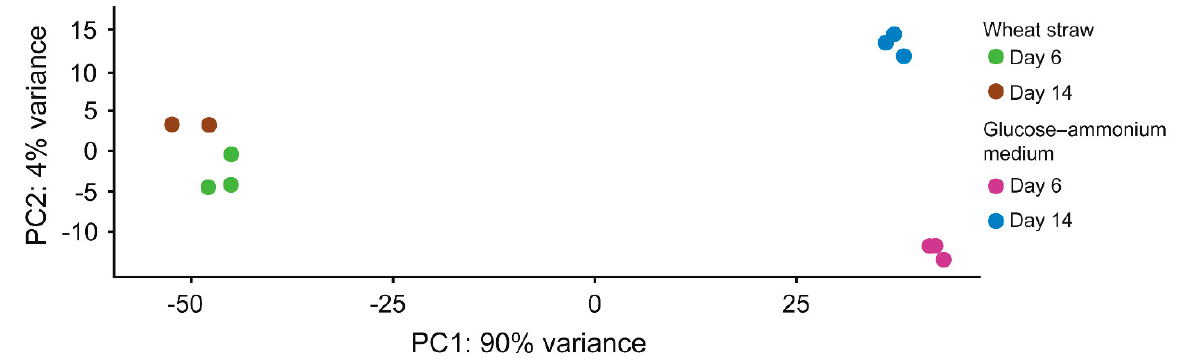
Figure 2. Principal component analysis of the log2 normalized RNA-seq read counts of 11 biological replicates of P. eryngii growing on wheat–straw and in glucose–ammonium medium for 6 and 14 days. The replicates are shown as colored circles according to the growth conditions: (i) green and brown for cultures of 6 and 14 days on wheat–straw, respectively; and purple and blue for 6 and 14 days of culture in glucose–ammonium medium, respectively.